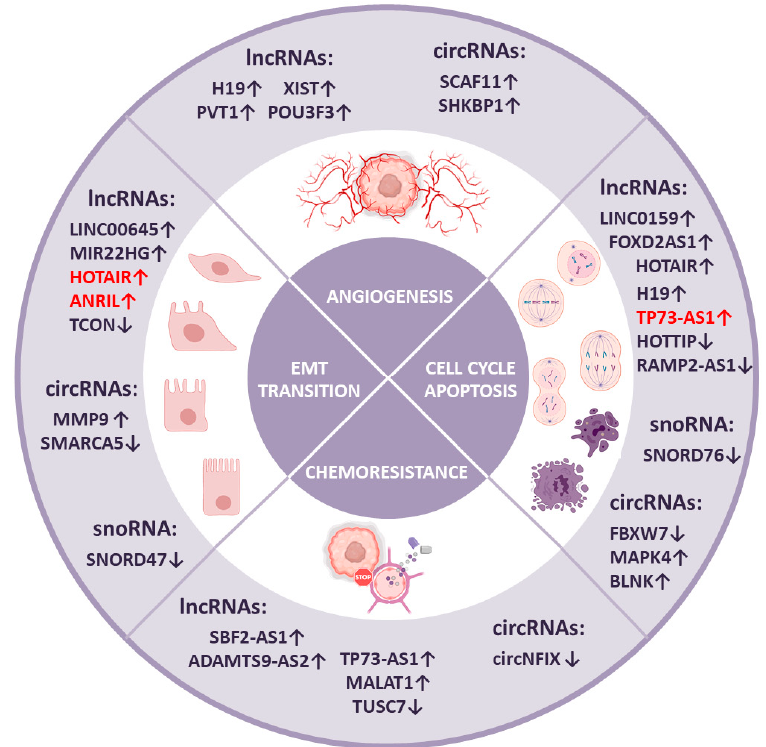
Figure 3. Contribution of lncRNAs, circRNAs, and snoRNAs in processes involved in brain tumors development. The arrow pointing up indicates overexpression of a particular ncRNA in brain tumor and the arrow pointing down indicates downregulation of the molecule. NcRNAs disrupted in gliomas are marked black and examples in medulloblastoma are marked red